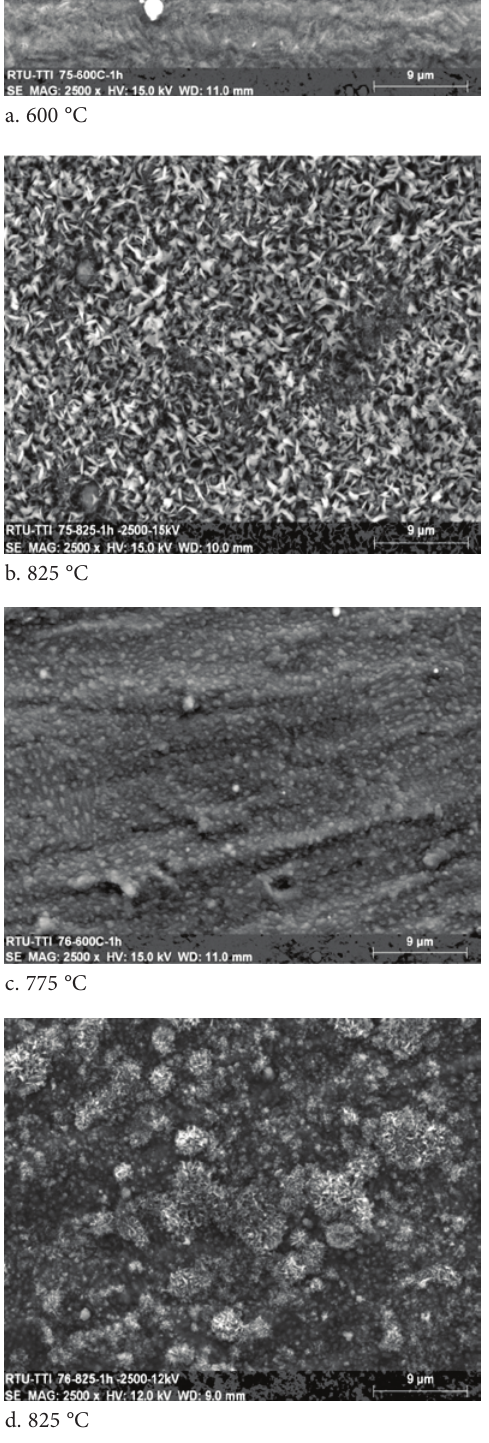
fig. 12. Changes in topography of samples 75 (a, b) and 76 (c, d) during heat resistance tests